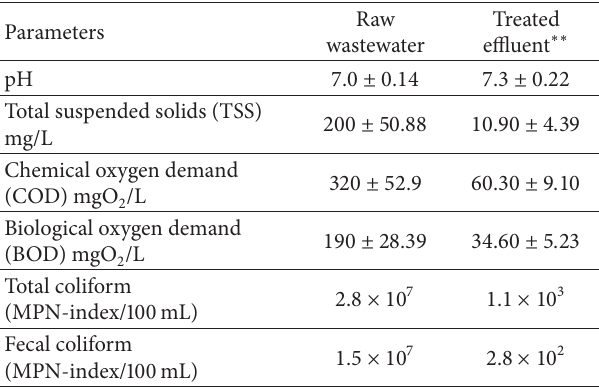
Table3:Physicochemicalandbacterialindicatorsofrawandtreated wastewater ∗